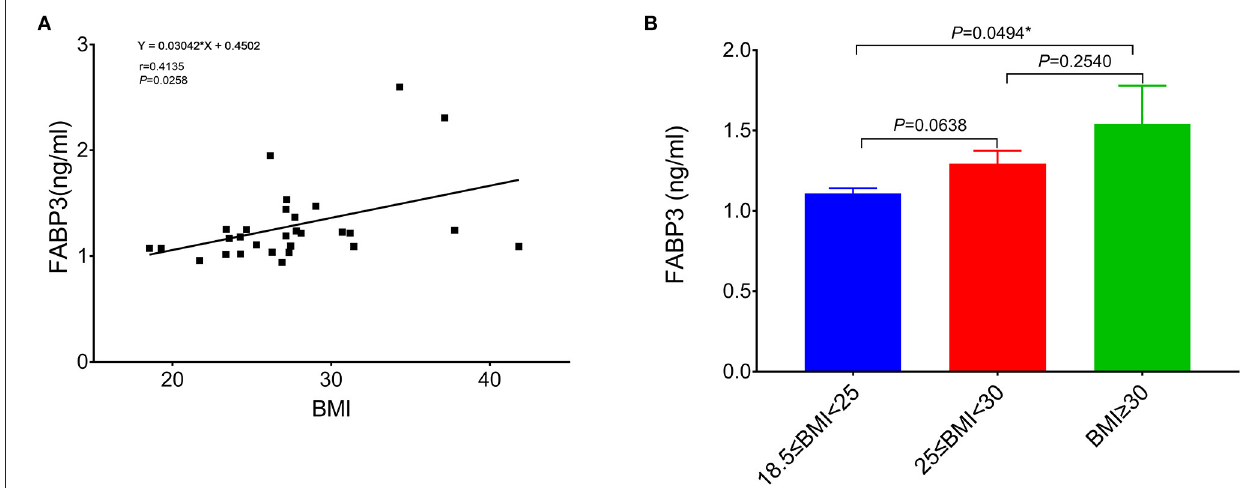
FIGURE 5 | The relation of BMI to FABP3 in the atrium. (A) The Pearson correlation analysis shows that the level of FABP3 in the atrium is significantly positively correlated with BMI. (B) Comparison of the level of FABP3 in the right atrium between the normal group (18.5 kg/m 2 ≤ BMI < 25 kg/m 2 , n = 10), the overweight group (25 kg/m 2 ≤ BMI < 30 kg/m 2 , n = 12), and the obese group (BMI ≥ 30 kg/m 2 , n = 7) and there is a significant difference of the level of FABP3 in the atrium between the normal group and the obese group. *Compared to the obese group, p < 0.05. Data are expressed as mean ± SEM. BMI, body mass index; FABP3, fatty acid binding protein